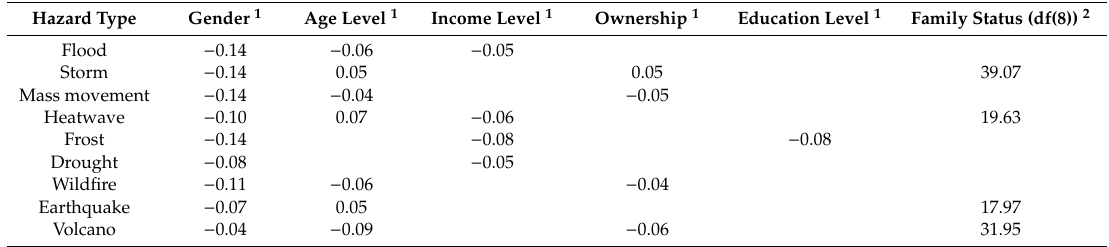
Table 3. Correlations between demographic variables and risk perception.